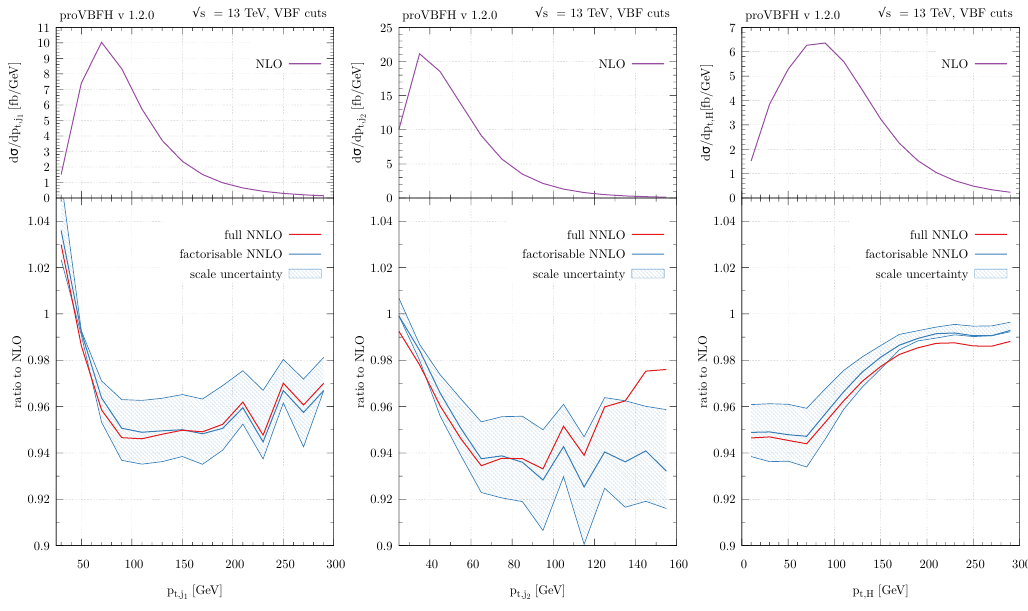
Figure 10. Upper panel: NLO prediction for VBF production with cuts for the transverse mo- mentum of the two leading jets and the Higgs boson. Lower panel: ratio of the factorisable NNLO prediction to NLO (blue) and of the full NNLO prediction to NLO (red). The blue bands represent the scale uncertainty of the NNLO factorisable